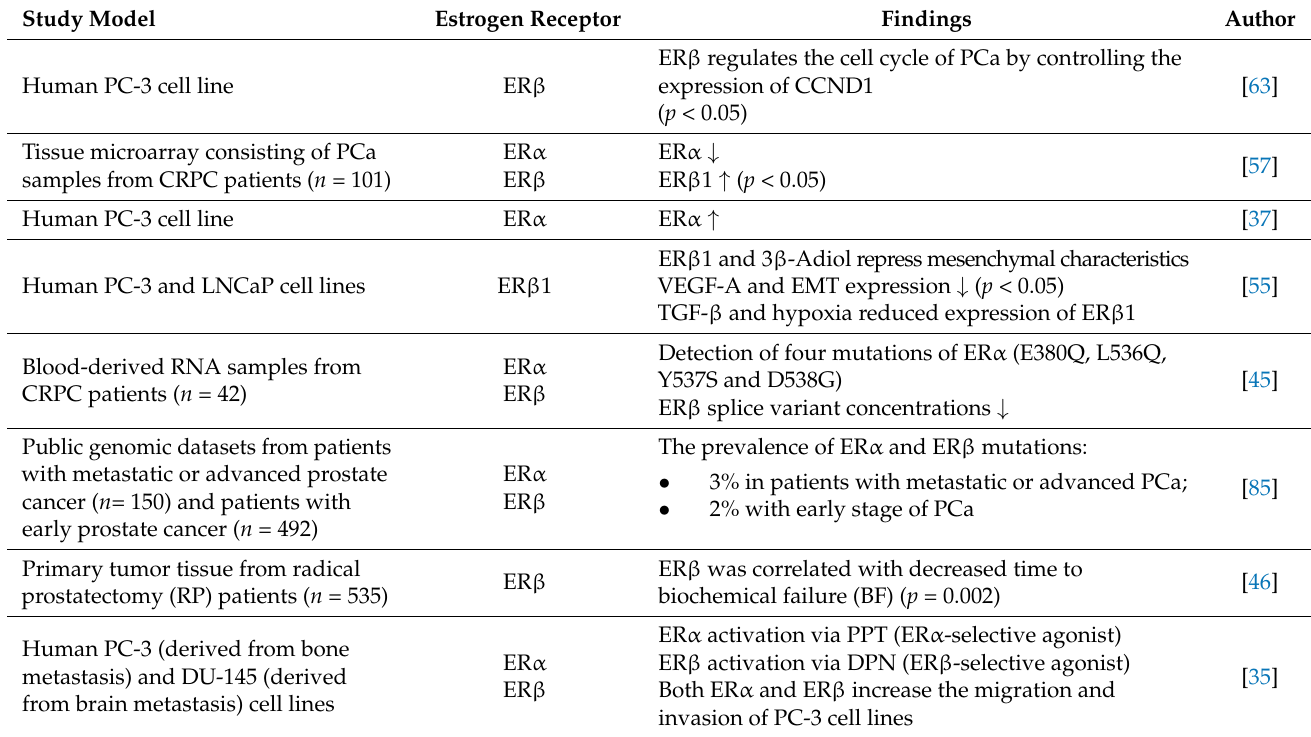
Table 1. Expression of ER α and ER β in castration-resistant prostate cancer study